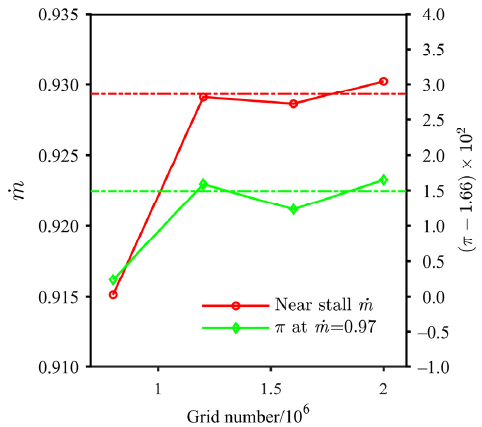
Figure 4. The near stall mass flow rate and the pressure ratio at . m = 0.97.